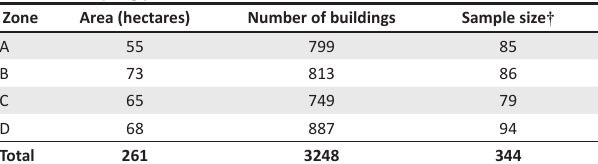
TABLE 1: Sampling procedure. Zone Area (hectares)